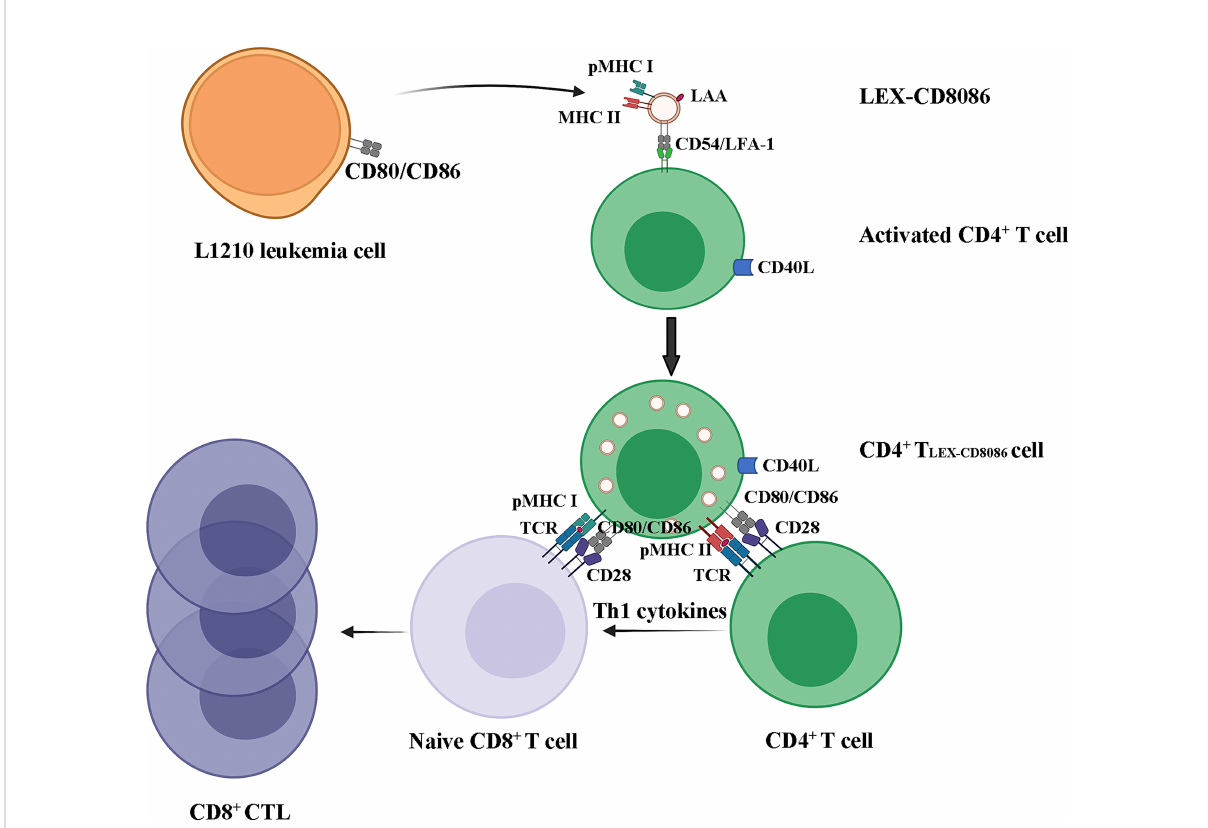
FIGURE 7 LEX-CD8086 targeting activated CD4 + T cells to stimulate a leukemia antigen-speci fi c CD8 + T cell response. LEX-CD8086 carrying pMHC I, CD80 and CD86 are fused with activated CD4 + T cells and become CD4 + T LEX-CD8086 , and CD4 + T LEX-CD8086 expressing CD40L and acquired exosomal pMHC I, CD80 and CD86 stimulate antigen-speci fi c, naive CD8 + T cell responses via IL-2 secretion and CD40L, CD80, and CD86